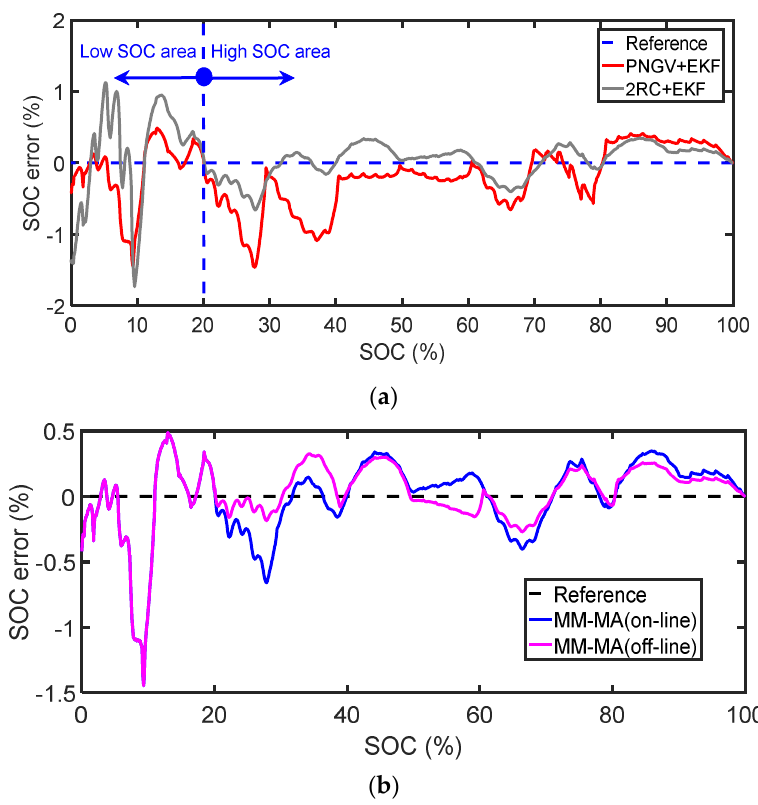
Figure 11. SOC estimation results using EKF method. ( a ) Comparison between the PNGV model and the 2RC model; and ( b ) SOC error based on MM-MA.